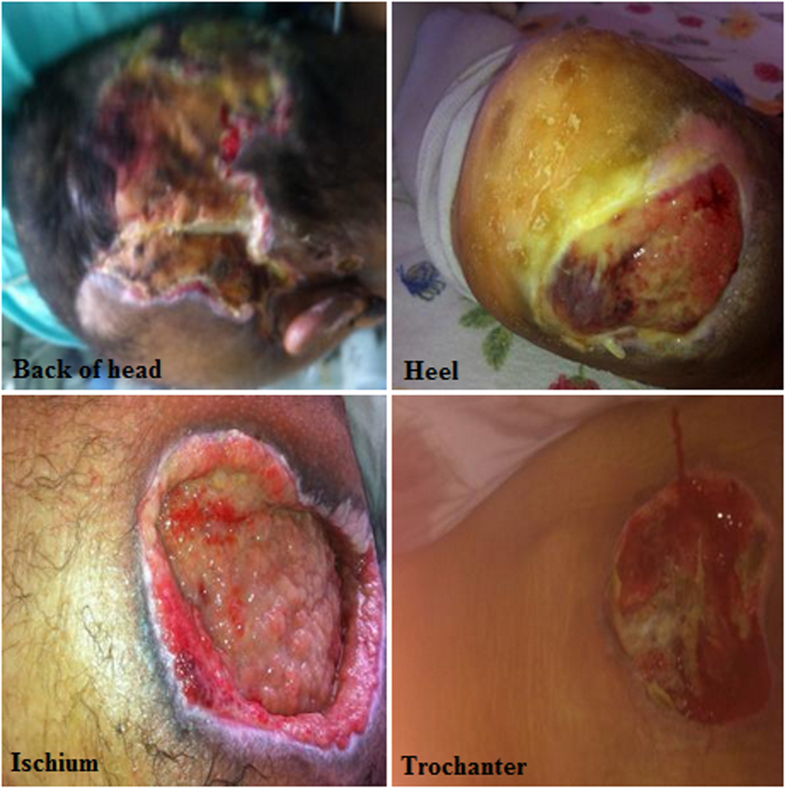
Common pressure ulcer locations.